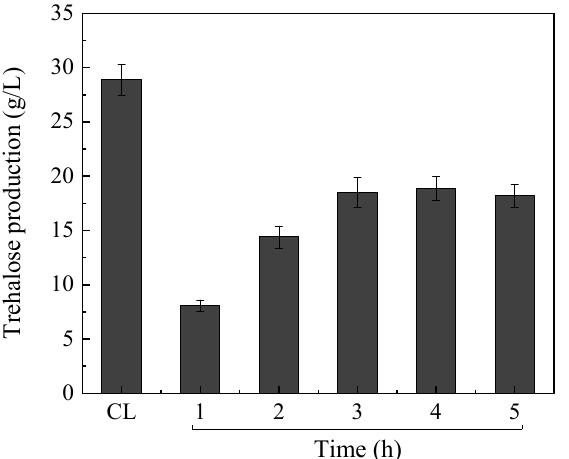
Figure 4. The effects of treatment time on cell permeabilization by Triton X-100. CL represents tre- halose production by crude cell lysates. The error bars represent the standard deviation of three independent replicates.